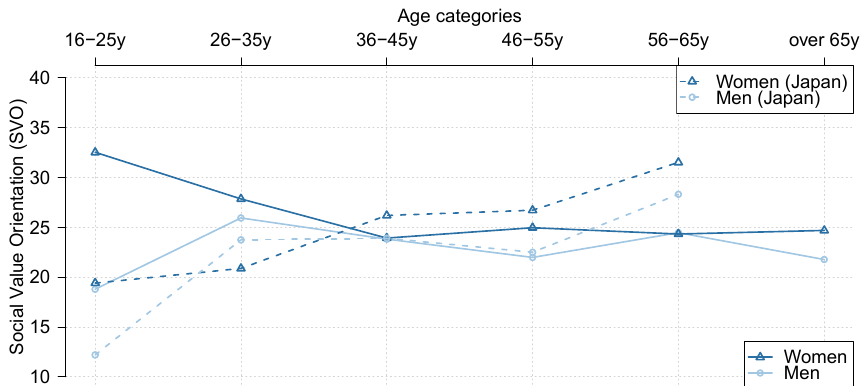
Figure A1. Average Social Value Orientation (SVO) of men and women in different age groups from Austria (solid lines) and Japan ([14]; dotted lines). Higher SVO scores indicate more altruistic-prosocial preferences.